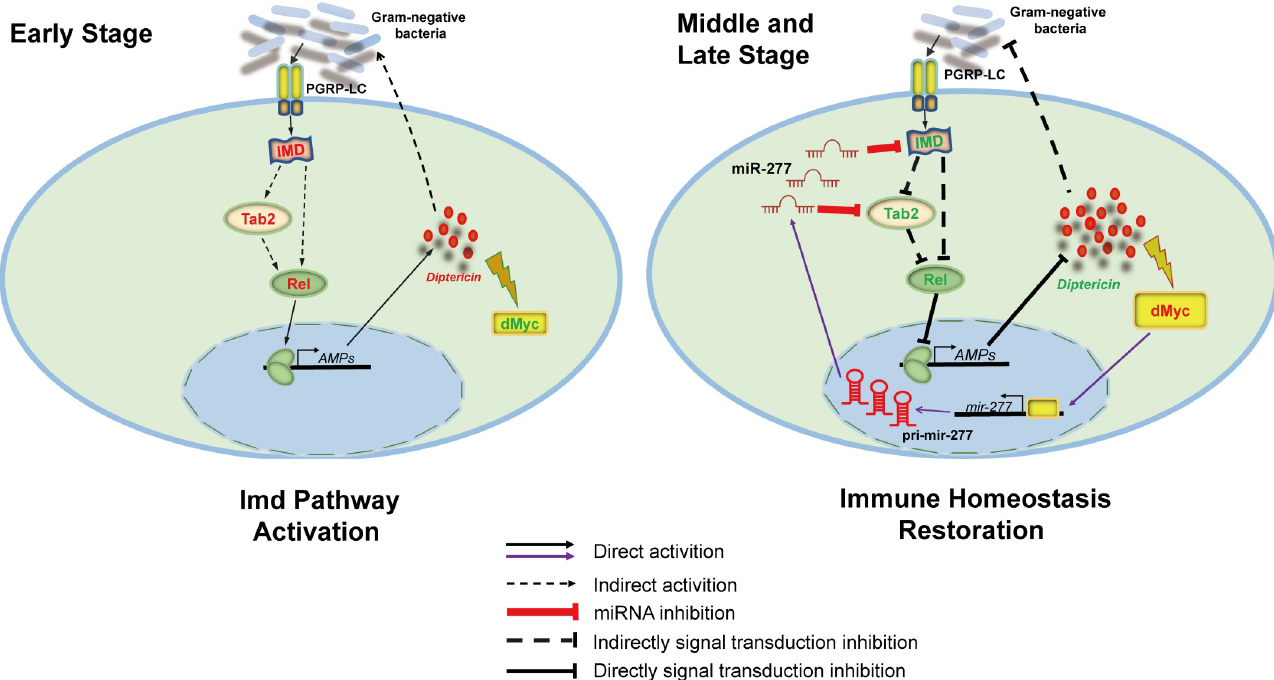
Fig 9. A potential molecular mechanism of dMyc restoring immune homeostasis of Drosophila Imd pathway. Our results suggested a model in which dMyc could restore Drosophila Imd immune homeostasis at the middle and late stage of E . coli infection. Left diagram: Drosophila Imd pathway is activated at the early stage of infection. Right diagram: Most of the bacteria have been eliminated at the middle stage of infection, next highly expressed antimicrobial peptides induce the up-regulated expression of dMyc. Then dMyc transfers into the nuclear to bind the upstream region of miR-277 to activate miR-277 transcription. Mature miR-277 further suppresses imd and Tab2 expression to down-regulate the Imd pathway immune response, and then assists cells restore immune homeostasis at the late stage of infection. Red word: up-regulation; Green word: down-regulation.